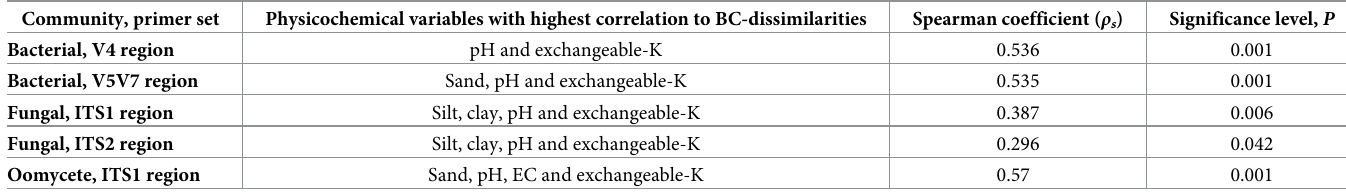
Table 3. Correlations between BC-dissimilarities and physicochemical variables as a function of PCR primer set a . Community, primer set